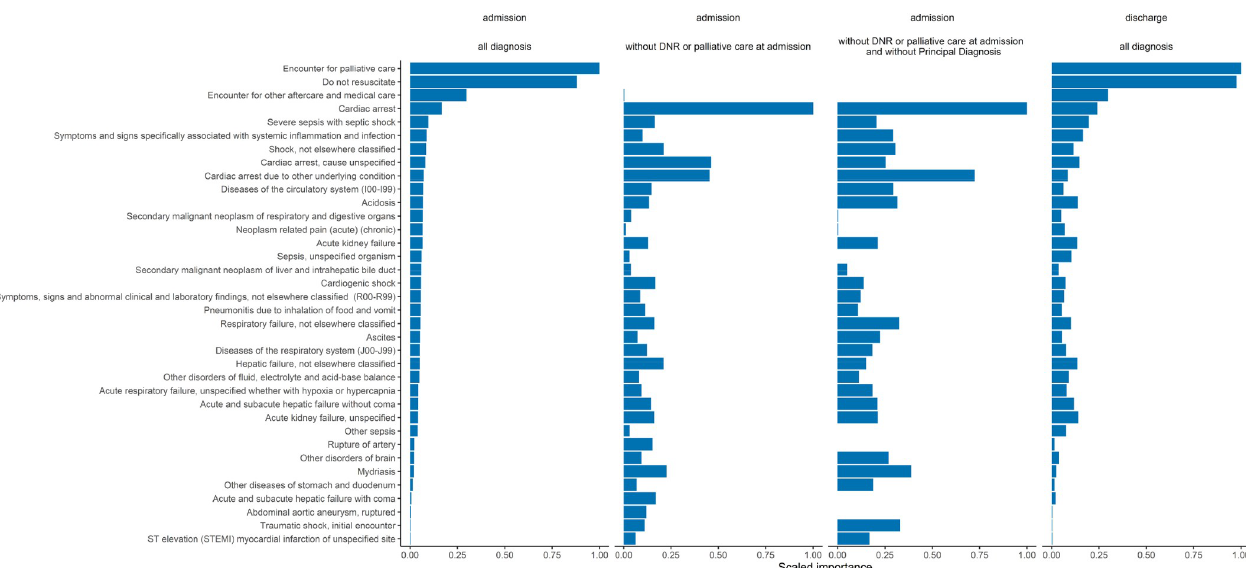
Fig 3. Variable importance plot for the models using ICD-10-CM diagnosis codes as predictors at admission and discharge, either using all diagnosis codes, without the Do Not Resuscitate or palliative care codes at admission, or without these codes and without the principal diagnosis. Whereas ‘Encounter for palliative care’, ‘Do not resuscitate’ and ‘Encounter for other aftercare and medical care’ are the three most important variables in the models with all diagnosis, ‘Cardiac arrest’ is the most important variable in the model with the excluded patients.